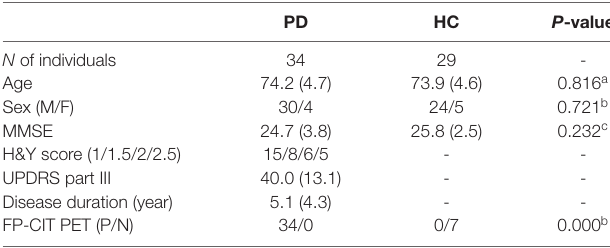
TABLE 1 | Demographics and clinical characteristics of the Parkinson’s disease (PD) and healthy controls (HC)